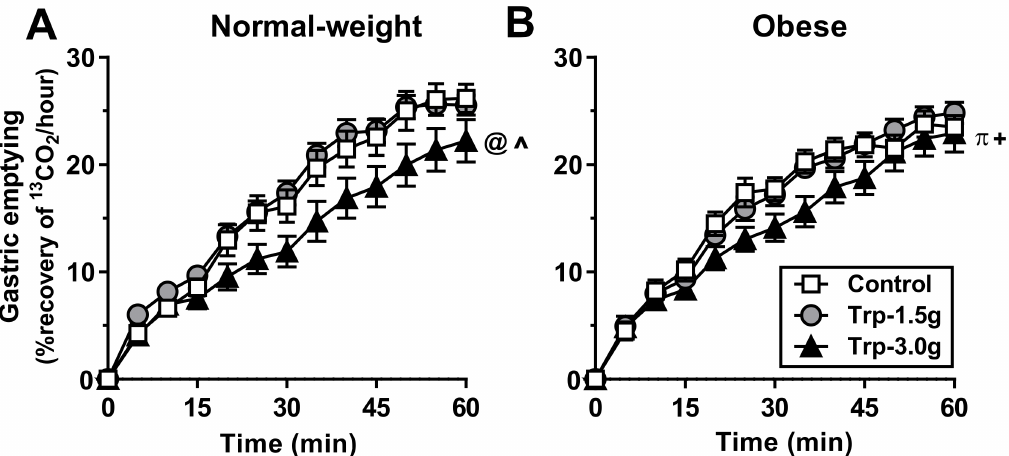
Figure 2. Gastric emptying of a mixed-nutrient drink, ingested at t = 0 min, 15 min after an intragastric infusion of tryptophan, at doses of 1.5 g (‘Trp-1.5g’) or 3.0 g (‘Trp-3.0g’), or control, in healthy normal-weight ( A ) and obese ( B ) volunteers. Data are means ± SEM, n = 16. Data were analyzed using repeated-measures ANOVA. Differences between treatments were assessed using paired t -tests, with adjustments for multiple comparisons made using Bonferroni’s correction. ( A ) Gastric emptying was significantly slower after Trp-3.0g compared with control (ˆ P < 0.05) and Trp-1.5g (@ P < 0.001); ( B ) gastric emptying tended to be slower after Trp-3.0g compared with control (+ P = 0.091), and was slower after Trp-3.0g compared with Trp-1.5g ( π P <